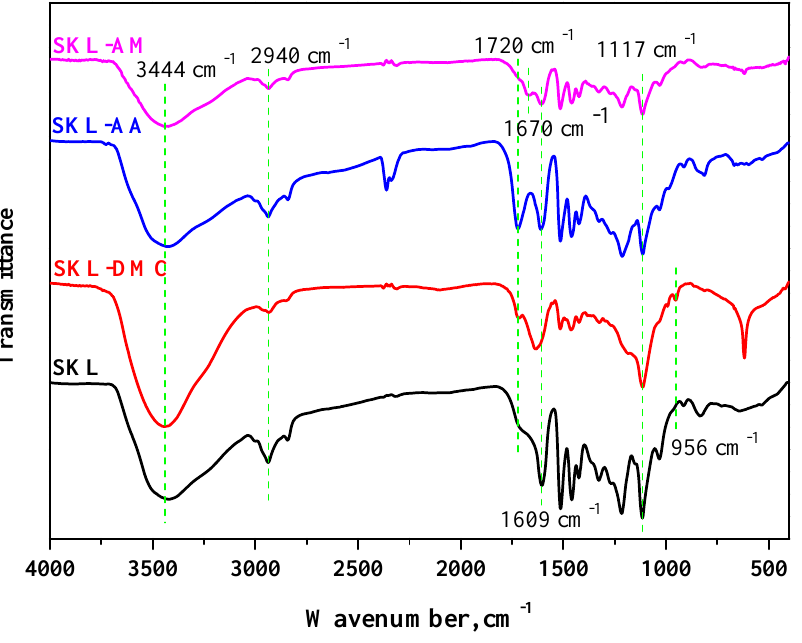
Figure 2. Fourier ‐ transform infrared (FTIR) spectra of SKL and SKL copolymers. Figure 2. Fourier-transform infrared (FTIR) spectra of SKL and SKL